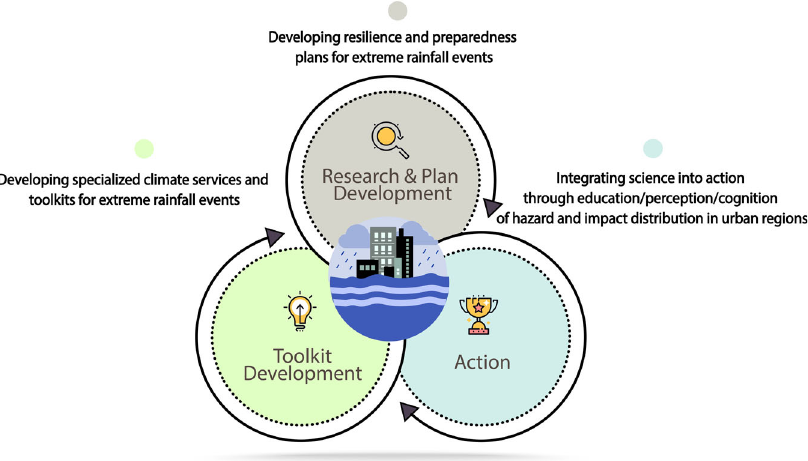
Fig. 1 Diagram showing elements to be considered for building communities resilient to extreme urban fl ooding induced by extreme rainfall